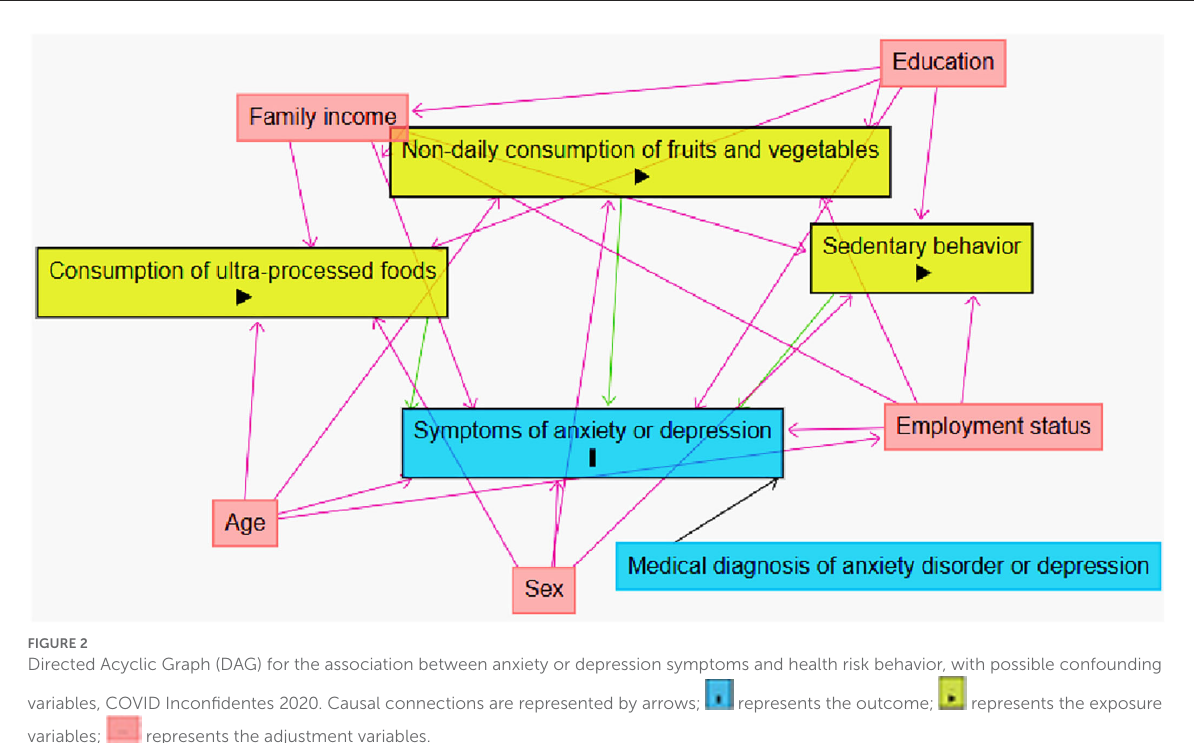
FIGURE2 Directed Acyclic Graph (DAG) for the association between anxiety or depression symptoms and health risk behavior, with possible confounding variables, COVID Inconfidentes 2020. Causal connections are represented by arrows; represents the outcome; represents the exposure variables; represents the adjustment